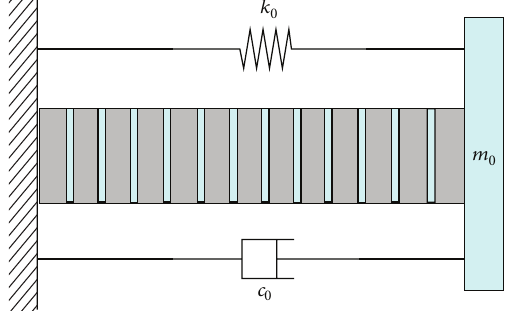
Figure 11: Schematic representation of prestressed